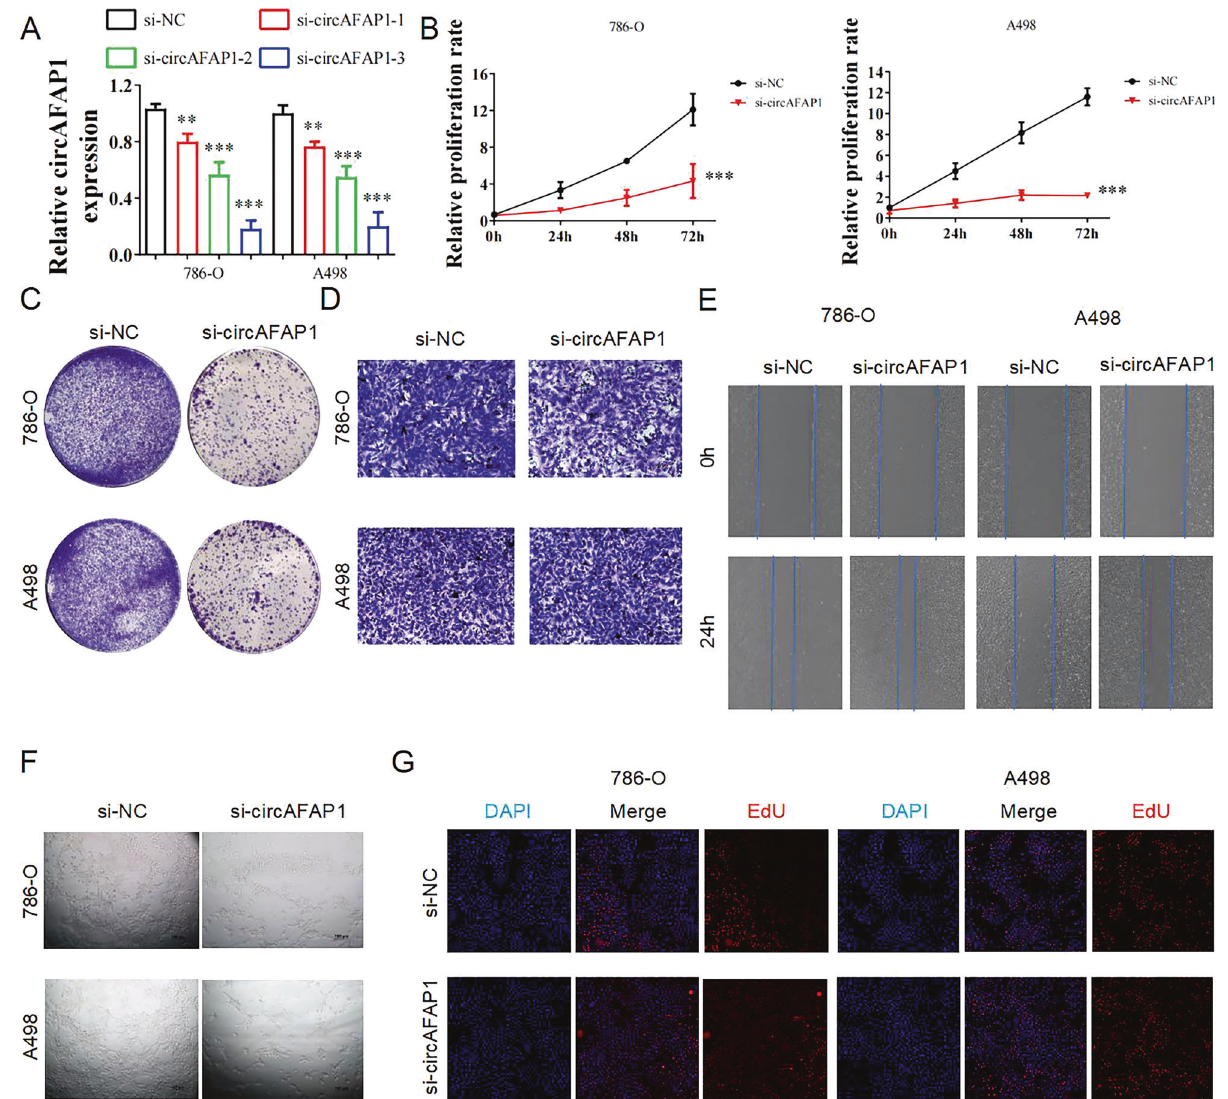
***represents p < 0.001. **represents p < 0.01. B , C CCK8 proliferation assays ( B ) and colony formation assays ( C ) displayed that the 786-O and A498 cells transfected with si-circAFAP1 have abrogated cell proliferation ability. ***represents p < 0.001. D Transwell assays were applied